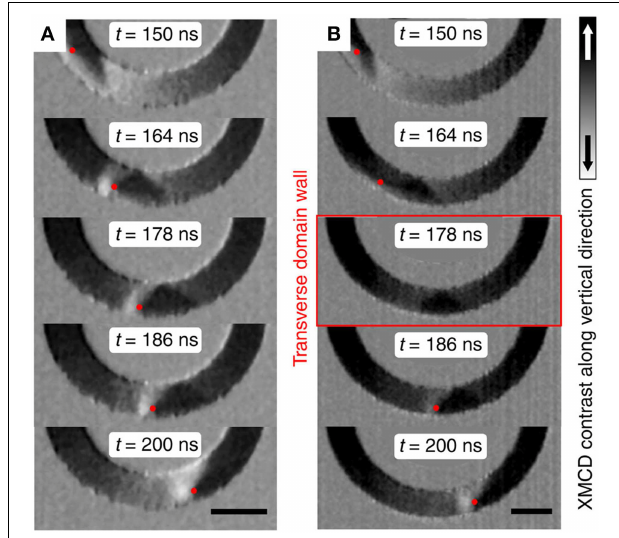
FIGURE 9 | From Bisig et al. [77]. Snapshots of vortex domain wall dynamics driven by 5 MHz counter-clockwise rotating field pulse in a ring of (A) 2.0 µ m and (B) 2.5 µ m